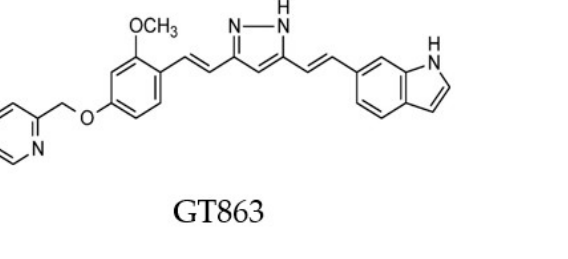
Figure 1. Structures of GT863 and curcumin. One of the main challenges in the development of therapeutic agents for AD is the inhi- bition of oxidative stress and cell-membrane damage caused by highly cytotoxic A β o expo- sure. In SH-SY5Y cells, A β o exposure has been shown to increase reactive-oxygen-species (ROS) production and cause significant oxidative stress [6]. Oxidative stress has been implicated in the pathogenesis of various pathologies and human diseases—particularly neurodegenerative diseases, including AD [16,17]. Cell-membrane integrity is essential for cell function and survival. Chemical stimuli such as ROS induce peroxidation of plasma-membrane phospholipids, resulting in loss of plasma-membrane integrity [18]. Fur- thermore, the formation of pores of various sizes and properties in the plasma membrane also result in a loss of plasma-membrane integrity. A β o exposure causes chemical disrup- tion of the plasma membrane, forms ion-channel pores in the plasma membrane [19], and act similar to surfactants, disrupting the plasma-membrane lipid bilayer and injuring neu- rons [20]. However, there are no reports on the action of GT863 on cytotoxic A β o-induced oxidative stress and cell-membrane damage. In this study, we prepared the highly toxic HMW A β o including mainly protofib- rils, and the protective mechanism of GT863 against A β o-induced neuronal injury was investigated, with a focus on the plasma